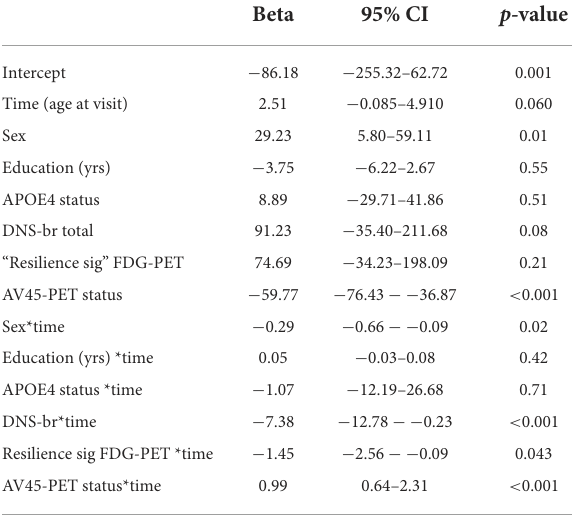
TABLE 6 Results of the mixed effect model to predict cognitive change in the full sample of 80 + participants (stable and